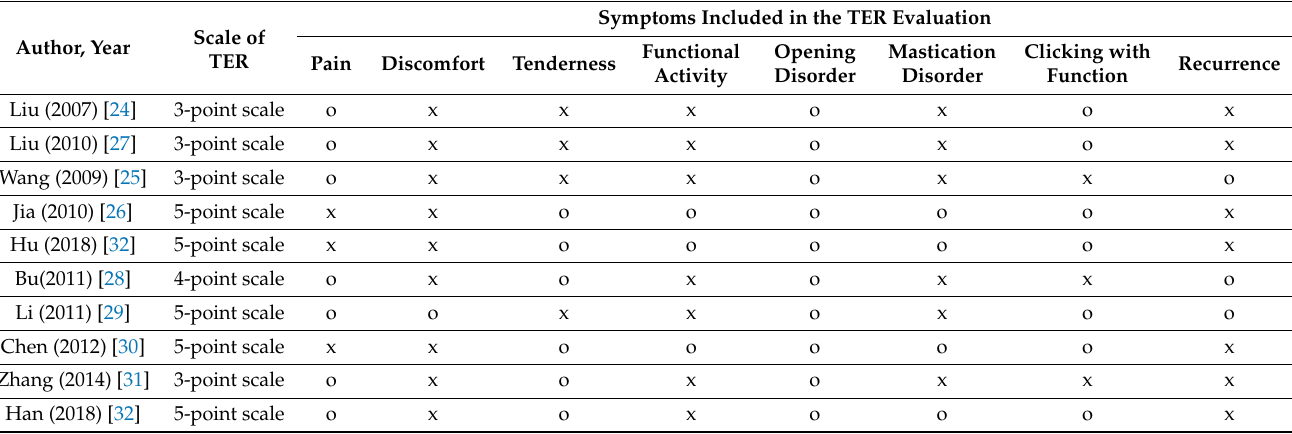
Table 3. Measurement method of outcome TER for TMD in the included